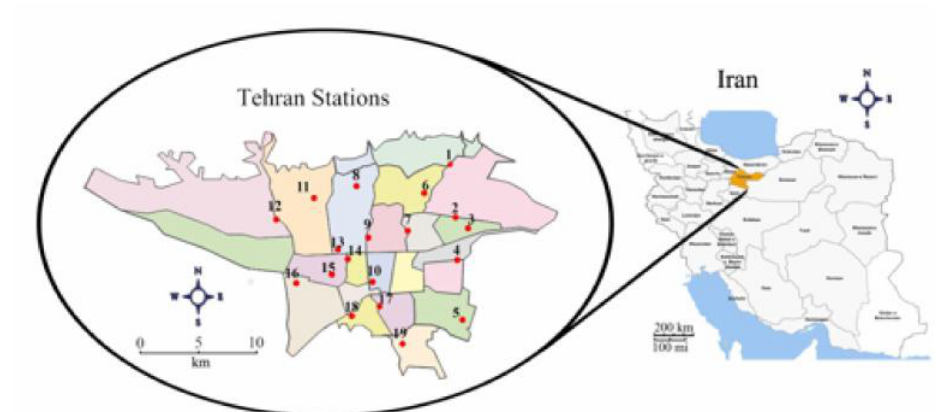
Fig. 1: The study area of research performance and air pollution monitoring stations in Tehran